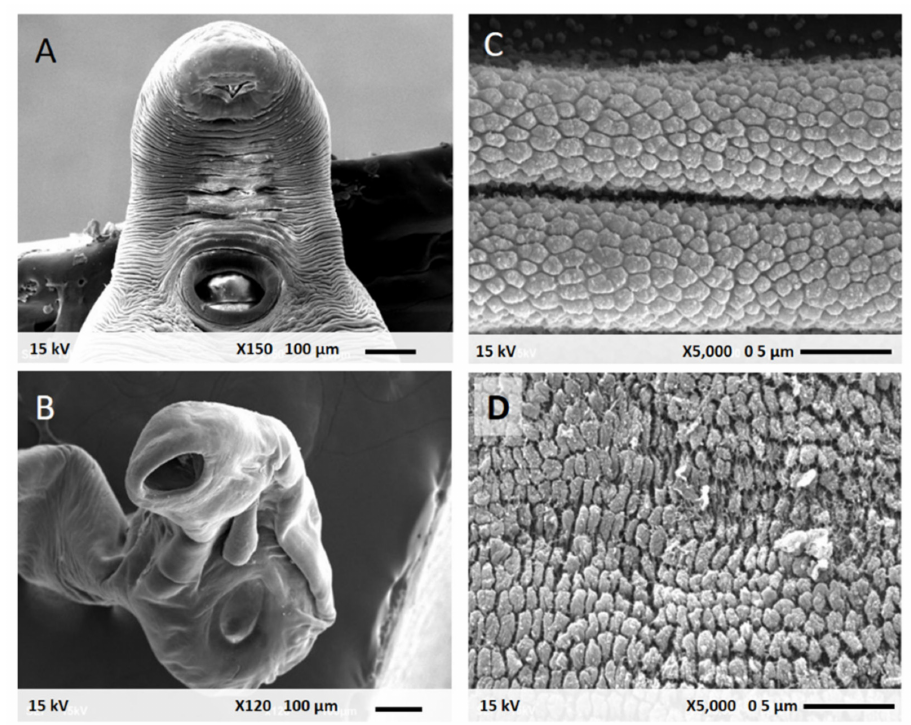
Figure 4. Scanning electron micrographs of P. gralli after incubation at 37 ◦ C for 24 h; ( A , B ) Viable parasite in 0.9% NSS and ( C , D ) Non-viable parasite exposed to hydrogel of PZQ 10 µ g/mL. Low 150 × (panels on the left-hand side) and high magnification 5000 × (panels on the right-hand side).